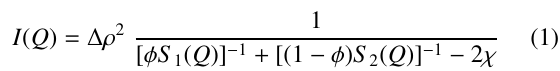
Figure 1. Comparison of the "static" scattering functions of short and long flexible linear polymers (Gaussian coils) and a mixture of both (solid line) as computed using the RPA expression Eq. 1 and ϕ = 0 .